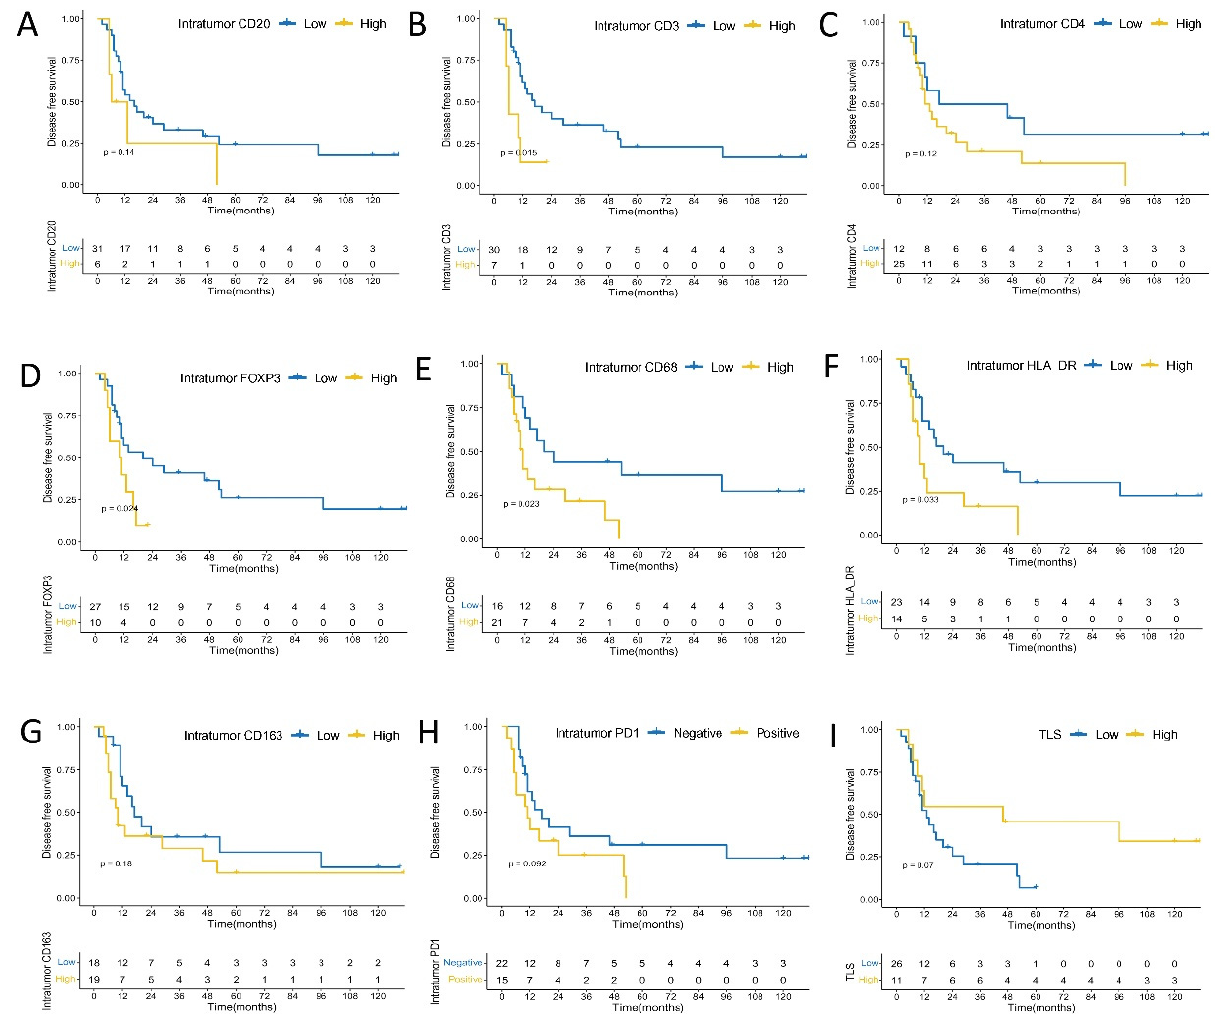
Figure 6. Kaplan–Meier analysis of intratumoral immune cells, TLS and disease free survival. ( A )